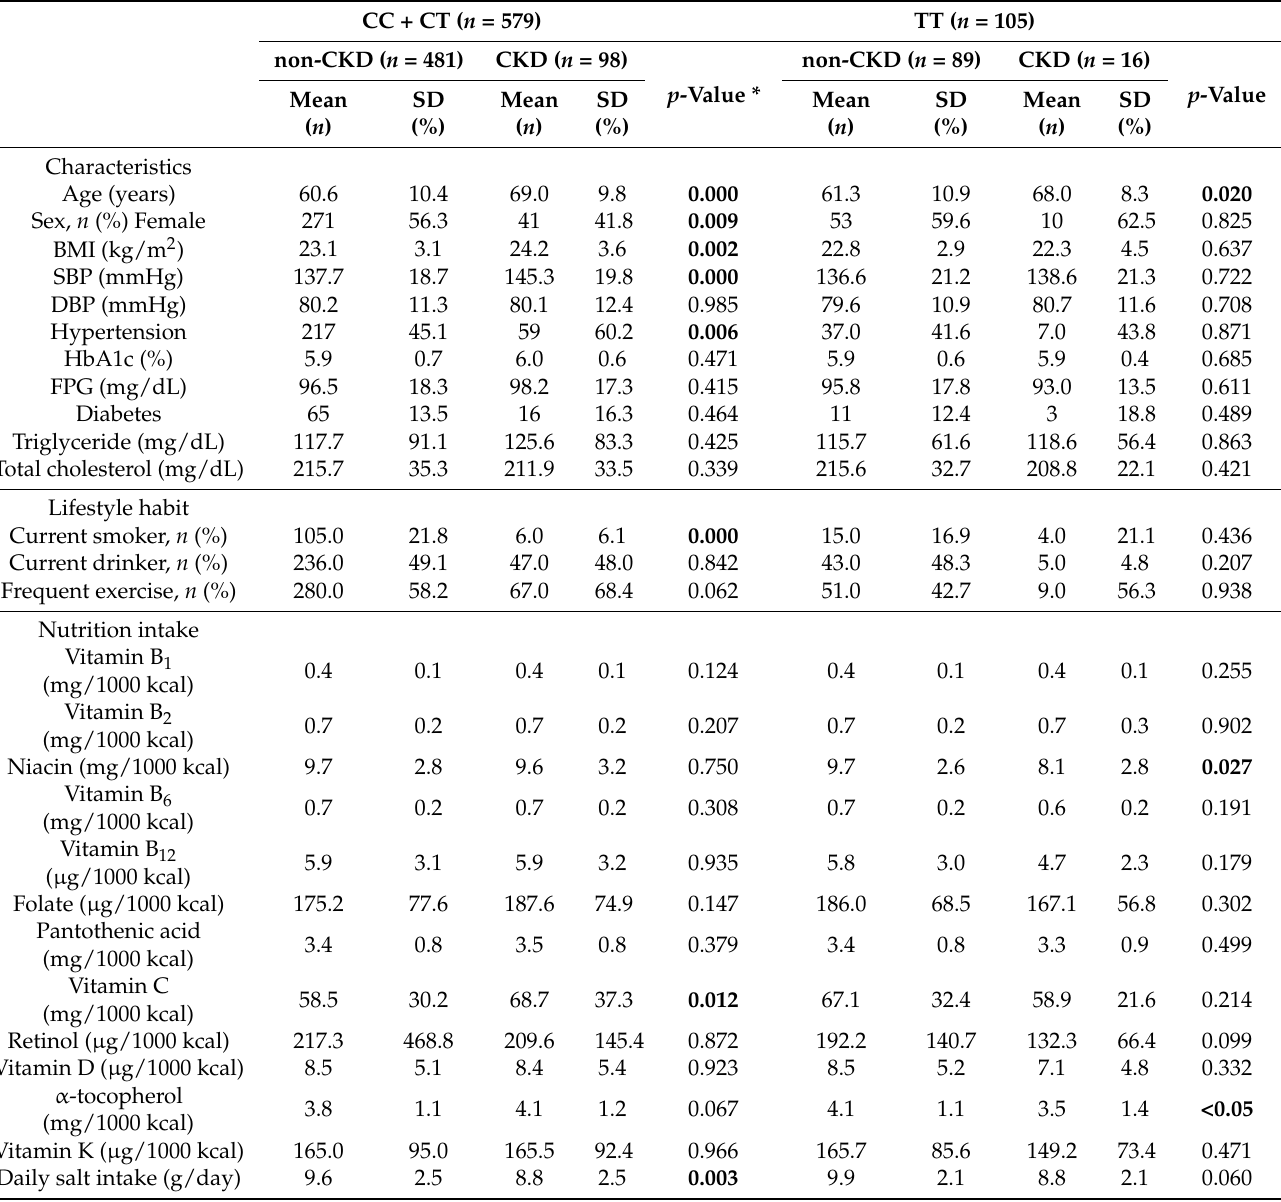
Table 2. Participant characteristics in different rs883484 genotypes and CKD